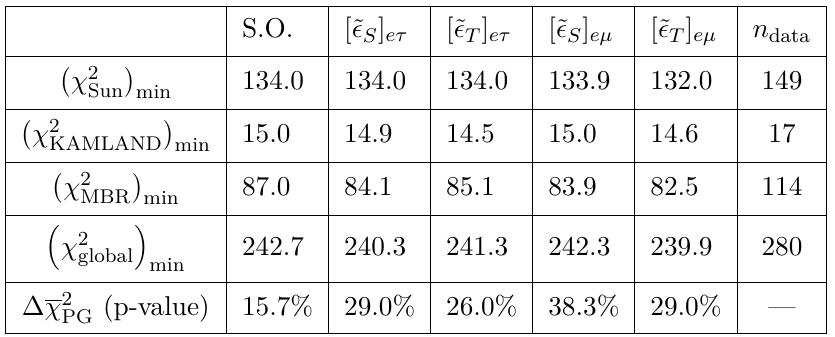
(cid:1) Summary of the analysis, here (cid:0) χ 2 is the local minimum χ 2 for experiment X min X=medium baseline reactor experiments (MBR), KamLand and solar experiments for standard neutrino oscillations (S.O.) and for different NSI scenarios. Here, ∆ χ 2 as defined in eq. (4.1). The PG number of data points, n , are shown in the last data